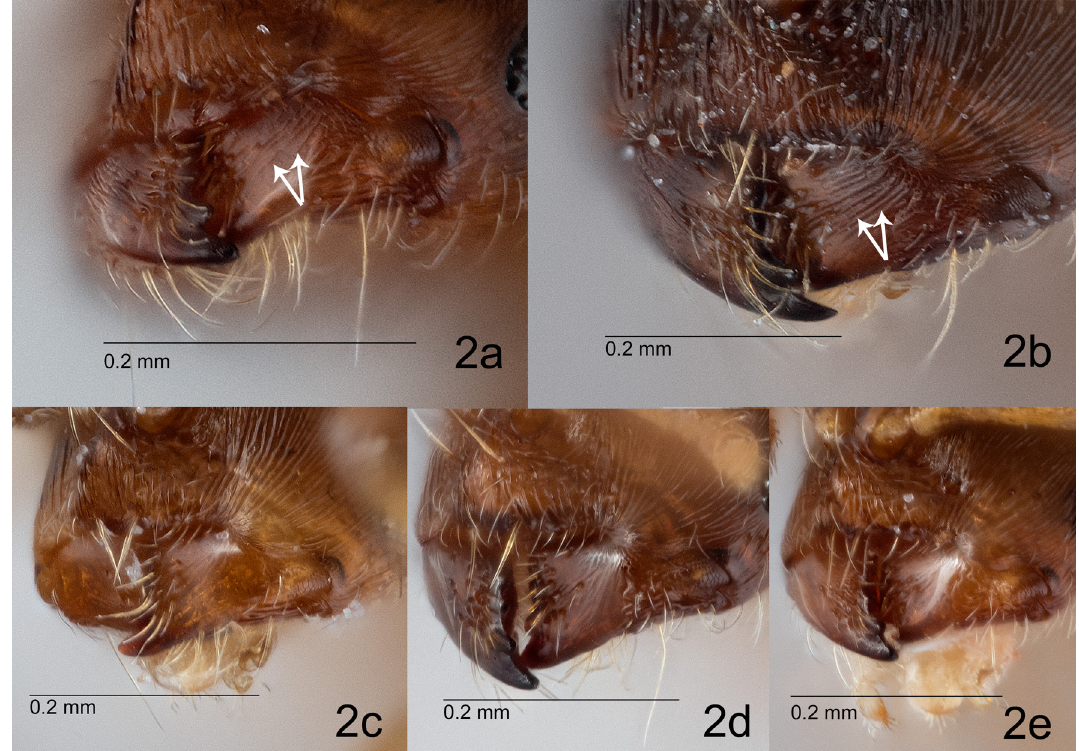
Fig. 2. Closeups of external mandibular surface for workers of 5 Thai species of Rhopalomastix Forel, 1900 (ZRC); white arrows indicate distinct striations on the external mandibular face. a . R. impithuksai Wang & Jaitrong sp. nov., paratype (ZRC_ENT00007608). b . R. robusta Wang & Jaitrong sp. nov., paratype (ZRC_ENT00013949). c . R. javana Wheeler, 1929, non-type (ZRC_ENT00000932). d . R. johorensis Wheeler, 1929, non-type (ZRC_ENT00007874). e. R. parva Wang & Jaitrong sp. nov., paratype